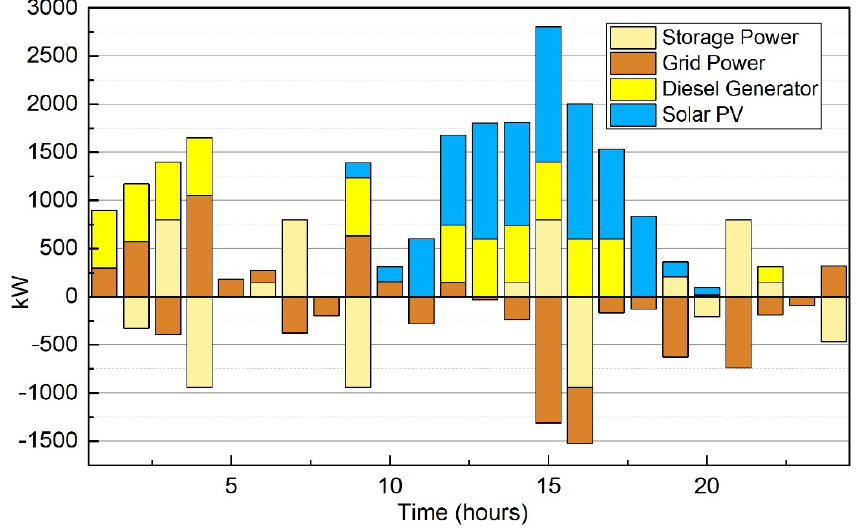
Figure 10. Optimal scheduling in case (4).